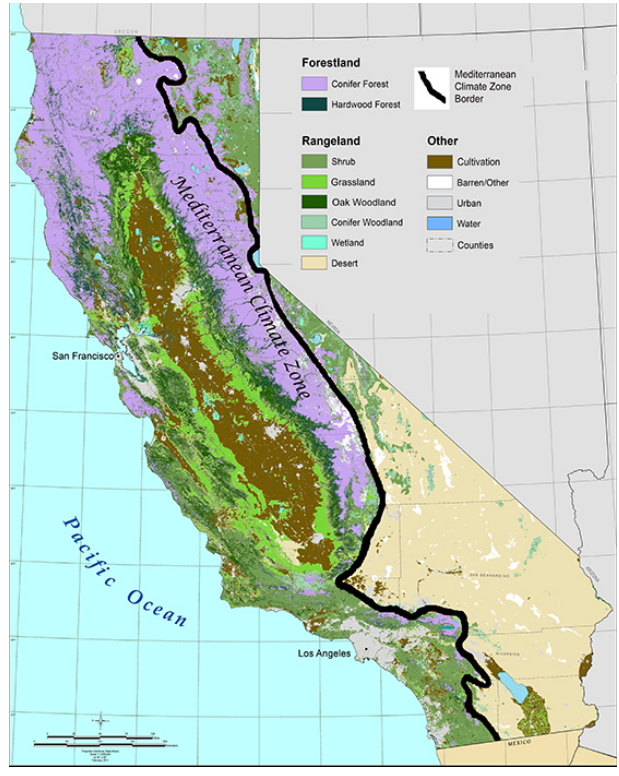
Fig. 1 . Oak woodlands, annual grasslands, and shrublands are the common rangelands within the Mediterranean climate zone of California. (Adapted from California Department of Forestry and Fire Protection–Fire and Resource Assessment Program 2006)